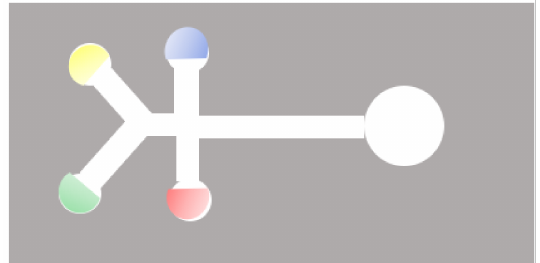
Figure 7. Schematic of a two-dimensional paper-based microfluidic device. Cellulose-based filter paper is precisely cut to produce hydrophilic microchannels which form five detection zones, each for the colorimetric detection of a specific